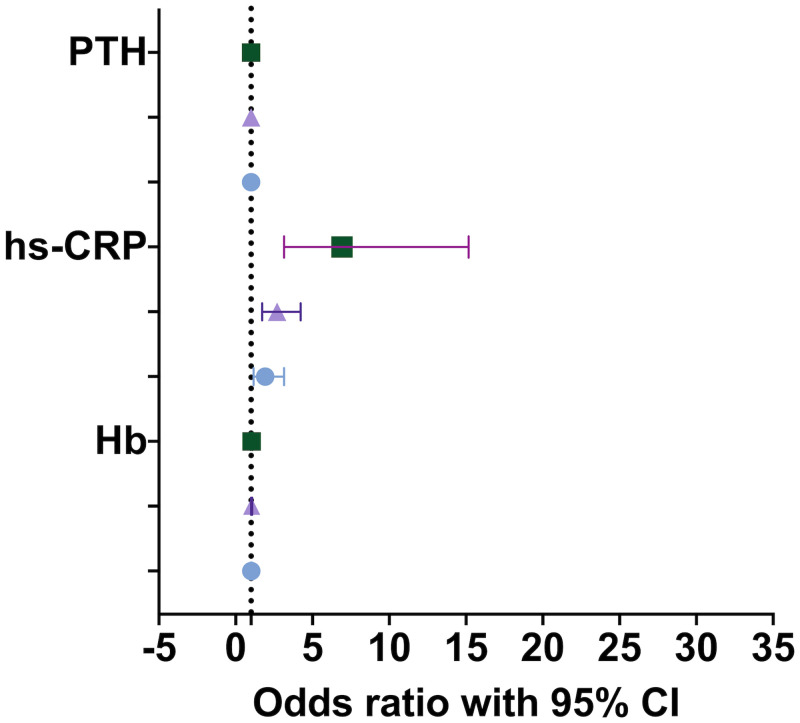
Single-factor logistic-regression analysis of the degree of skin itching in patients with uremic pruritus.The error bars represent the lower and upper limits of the 95% confidence interval. The symbol is a circle for mild itching, a triangle for moderate itching, and a square for severe itching. The dashed line in the figure indicates that the odds ratio is equal to 1.